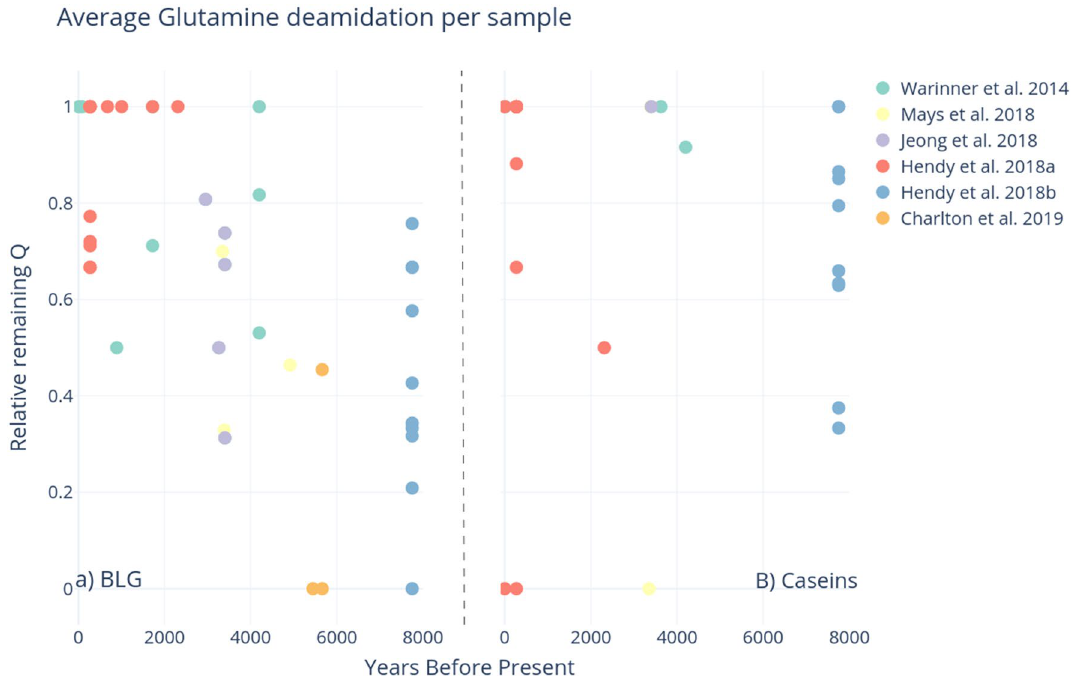
Figure 7. Average glutamine deamidation per sample, ( A ) BLG, ( B ) Caseins. The estimated age of the samples (years before present) is on the x-axis. Plots produced through deamiDATE 24